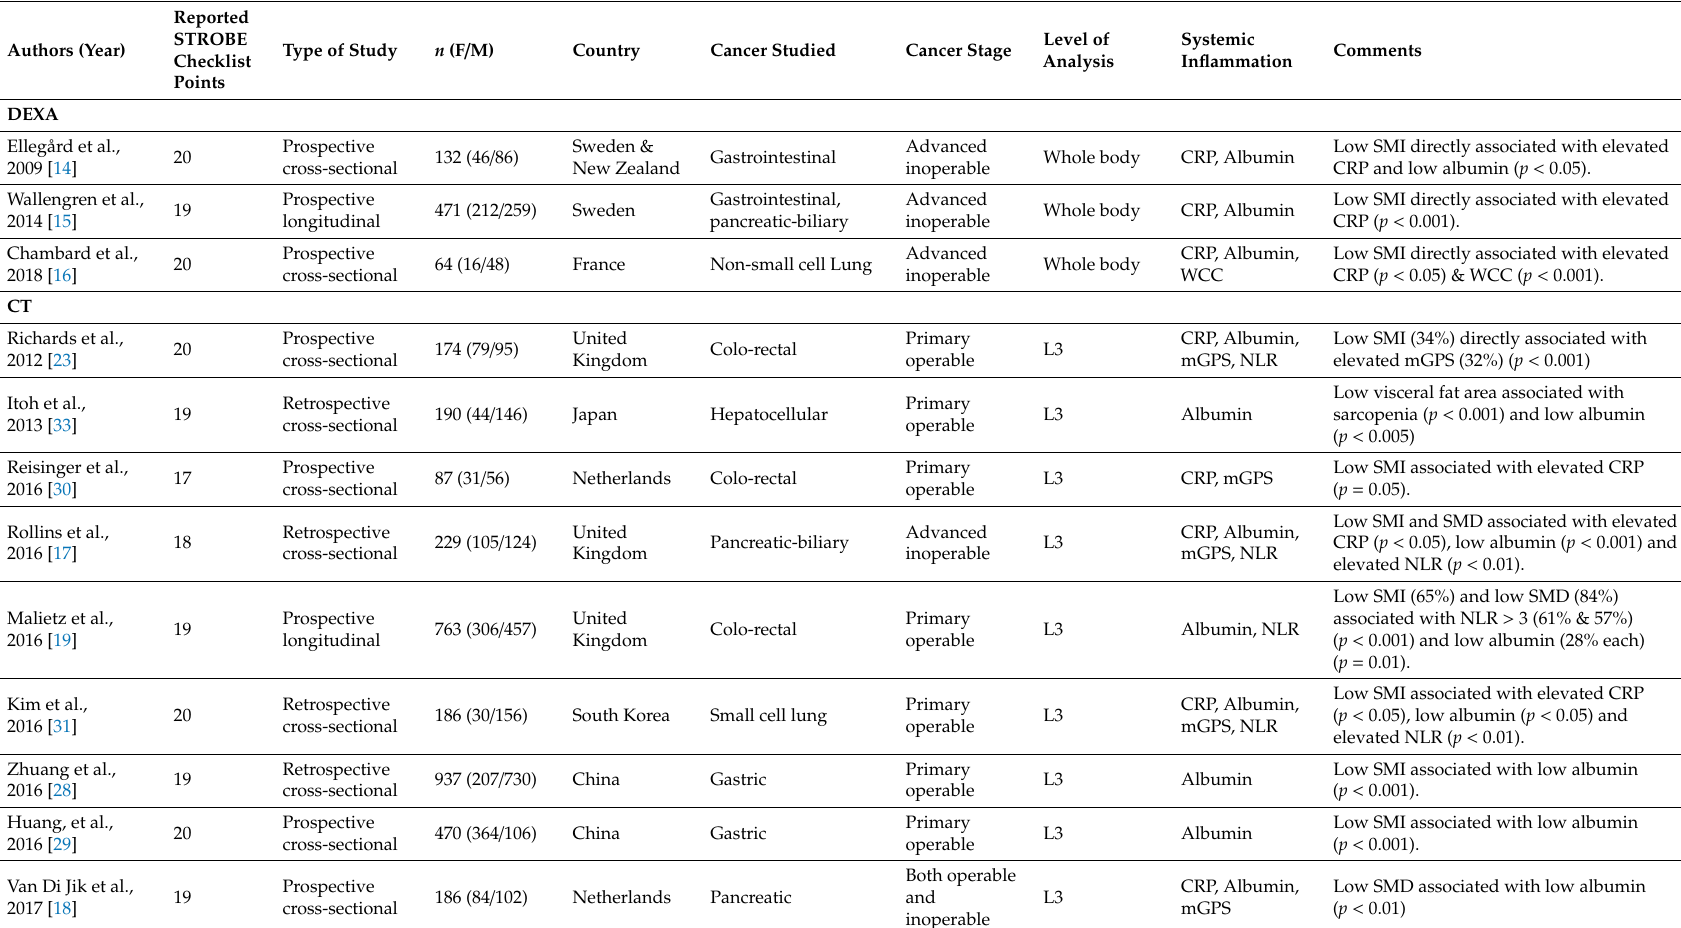
Table 2. Characteristics of included